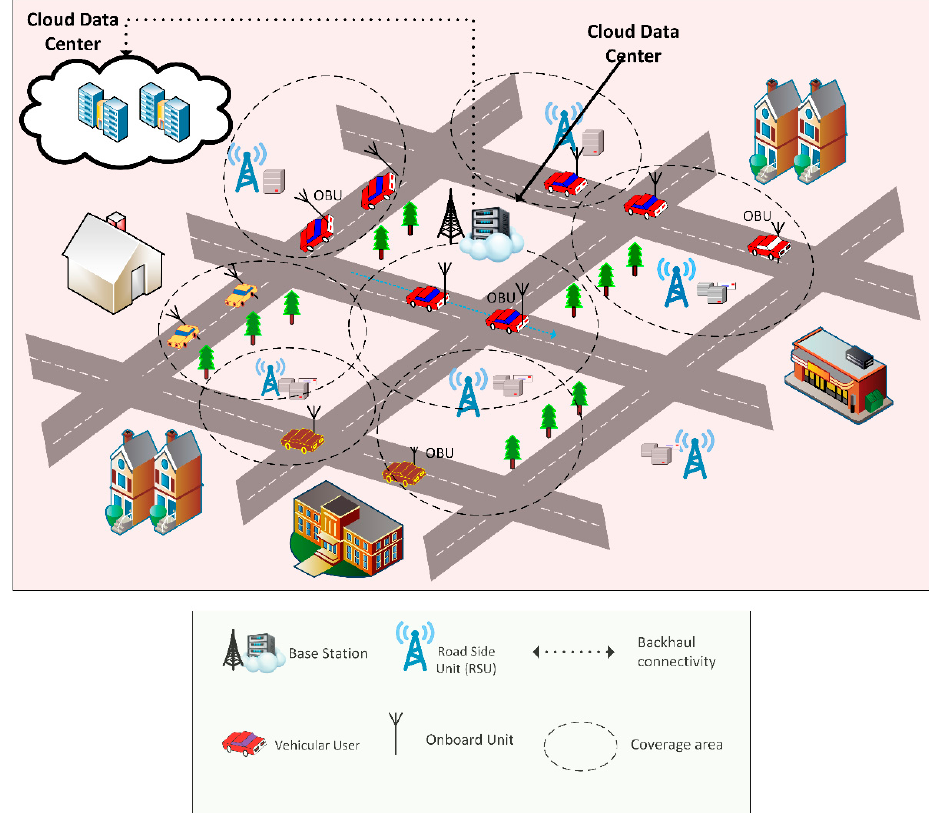
Figure 1. Vehicular edge network architecture.